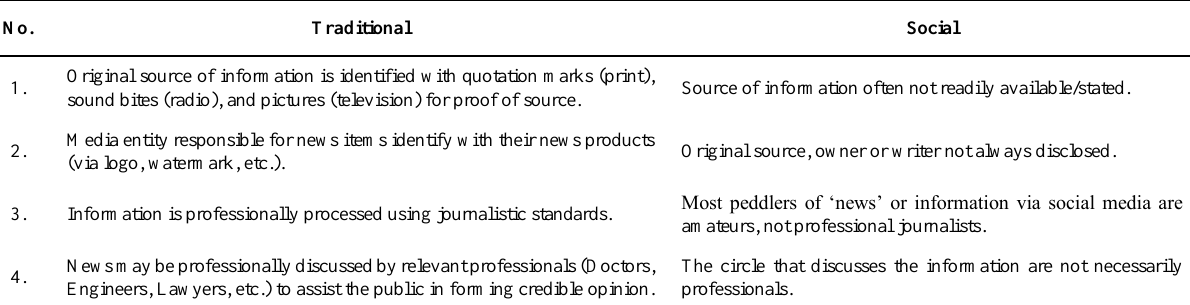
Table 1. Traditional Media versus Social Media